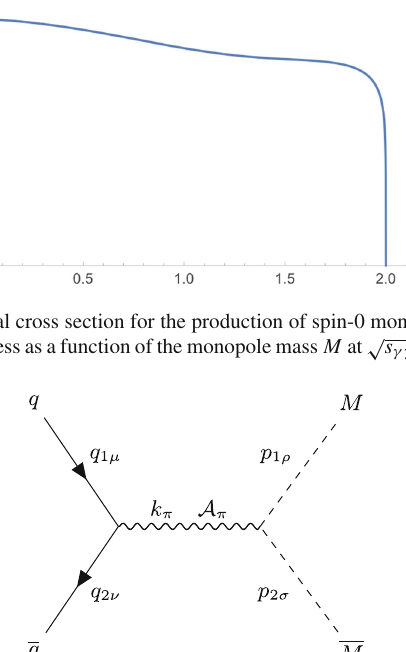
Fig. 5 Feynman-like diagram representing the DY process in a scalar monopole theory. The variable definitions are given in the